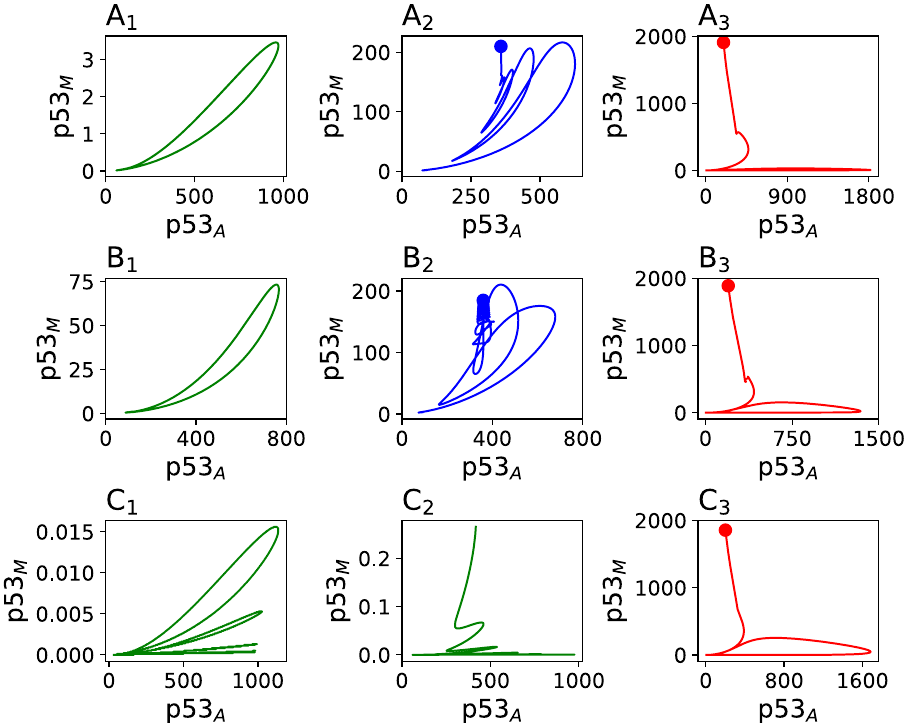
Figure 3. Dynamics on the phase plane for the time series results in the Fig. 2. Green color indicates active state, blue color apoptotic, and red color cancer state. The dot shows the attractor (end point of the trajectory).